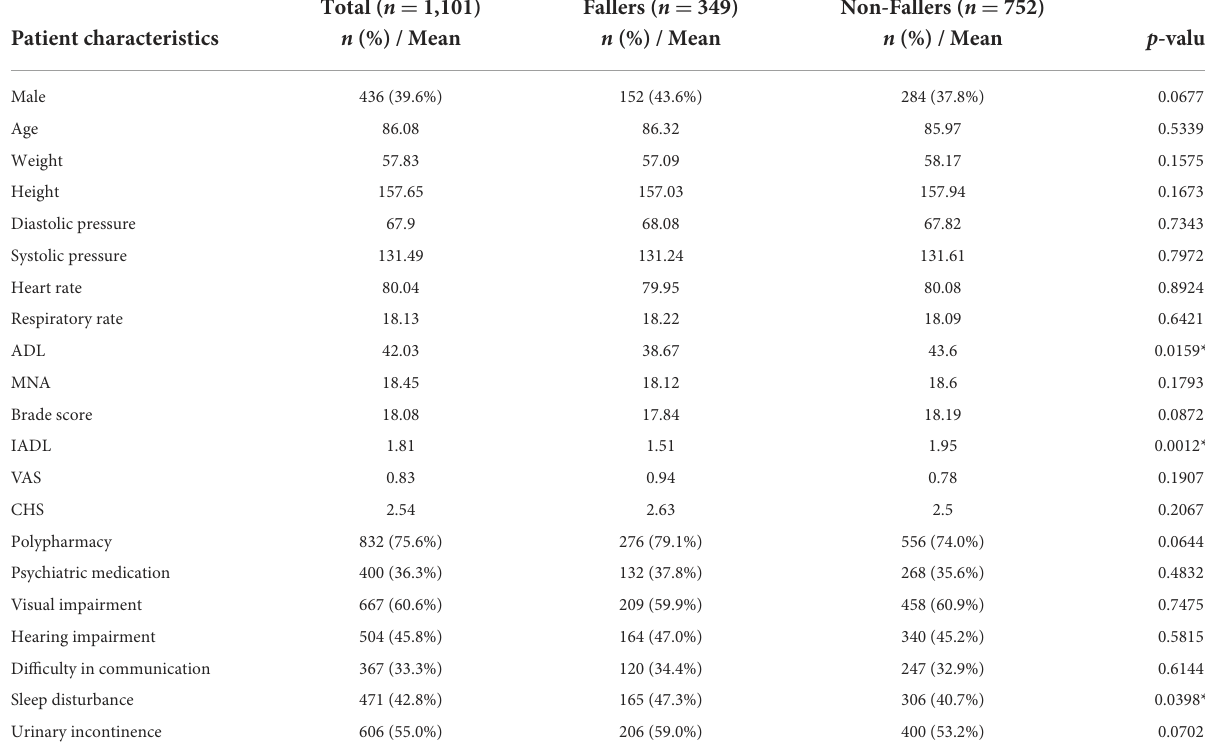
TABLE 2 Demographics and clinical factors of participants.